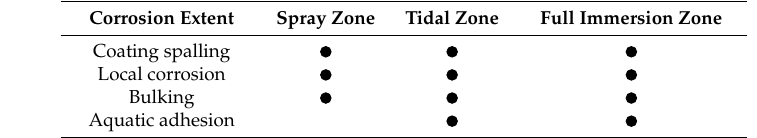
Table 2. Visual detection results of corrosion states within the protective device.